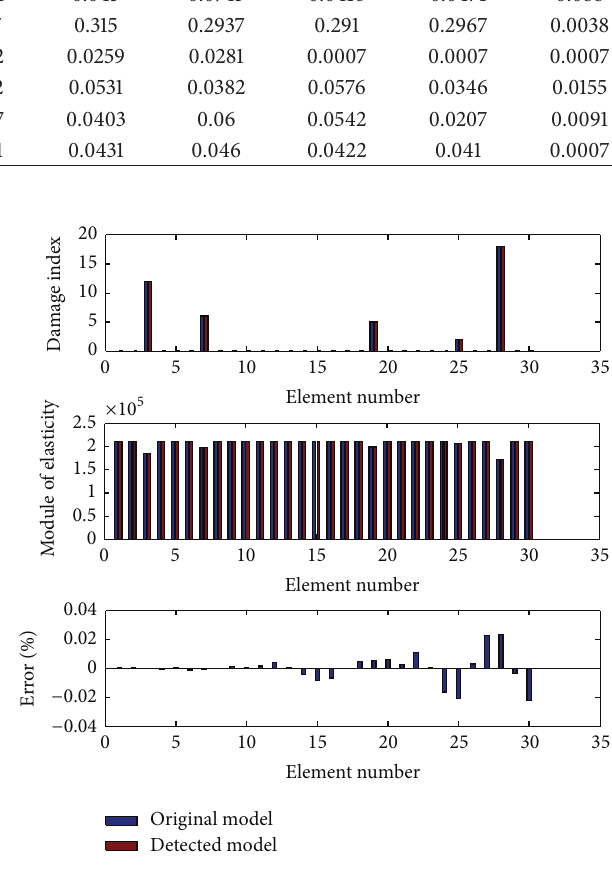
Figure 5: Detection of damage location and amount in elements 3, 7, 19, 25, and 28 and distribution of error in different elements with ADM